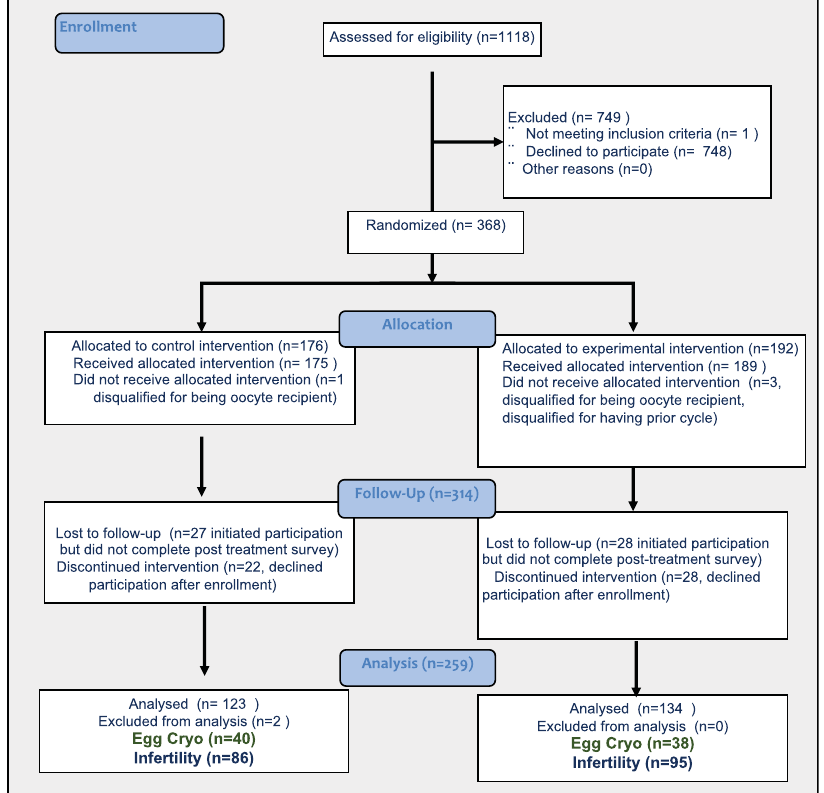
Fig. 1 CONSORT fl ow diagram. Flowchart demonstrating the number of patients who were screened, enrolled, randomized and participated in the